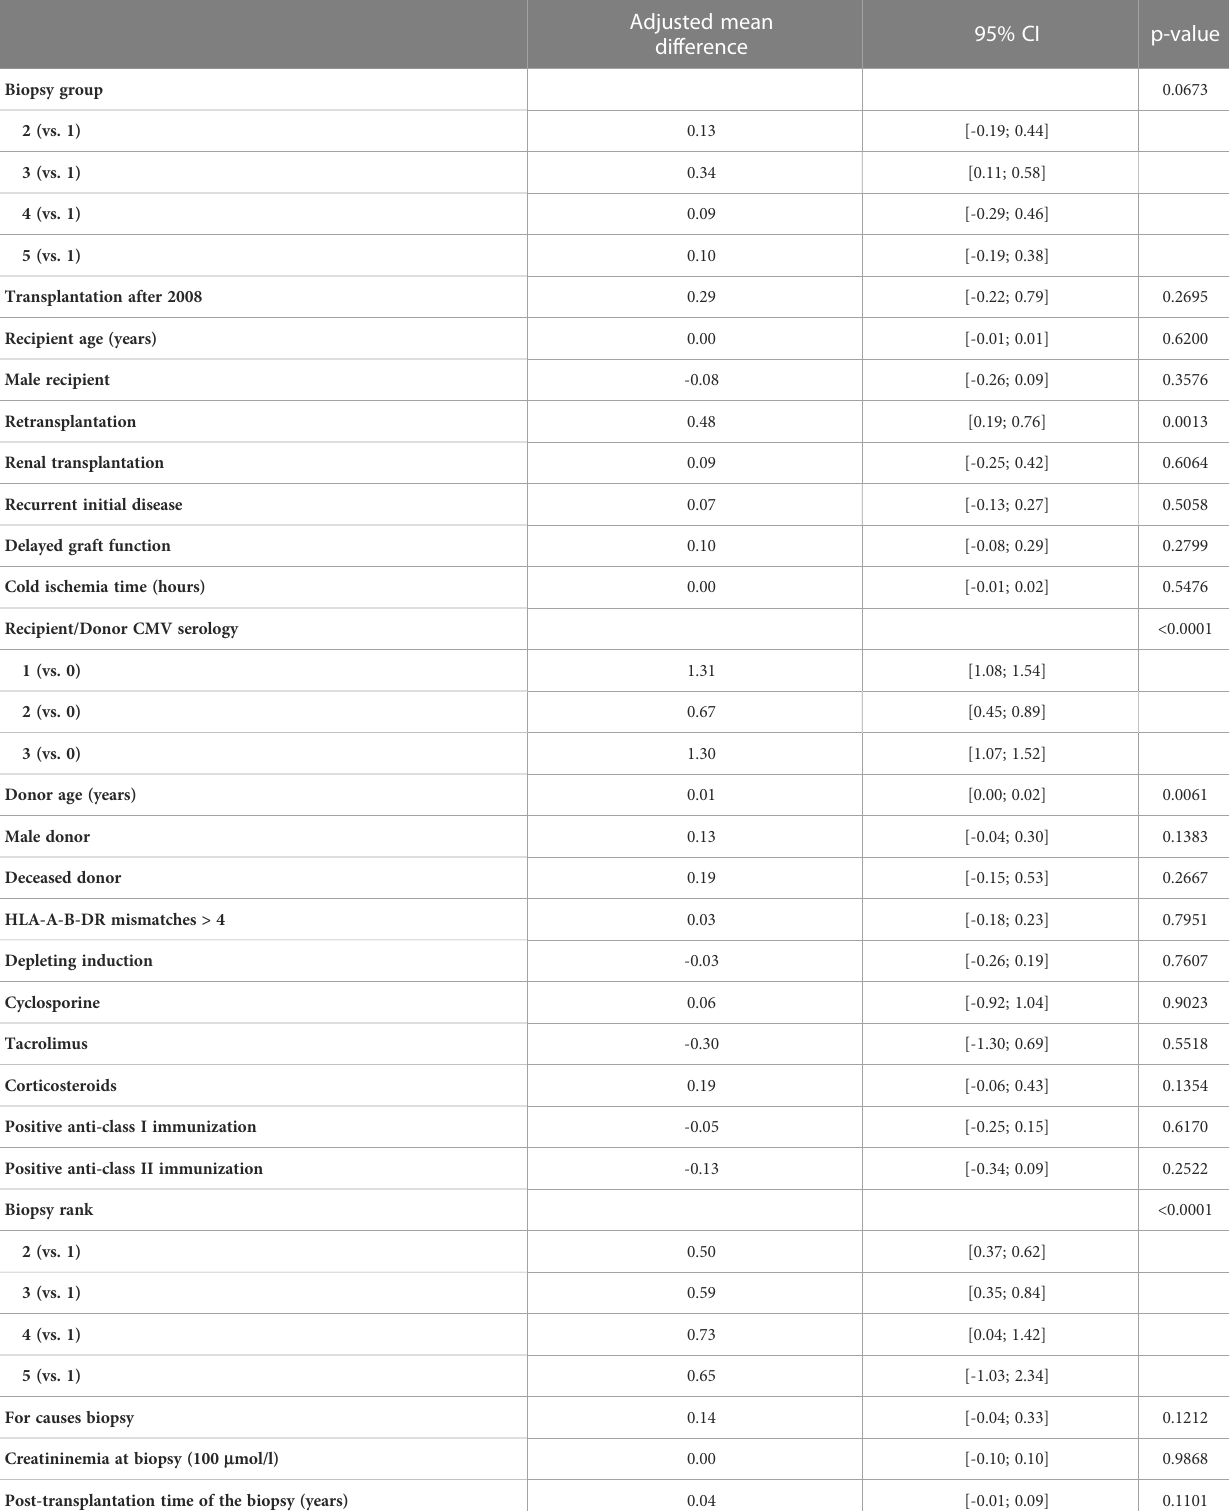
TABLE 6 Results of the multivariable linear mixed model of log of the ratio between CD28-CD8+ T cells in absolute number and Tregs in absolute number measured at the time of biopsy (5 biopsy